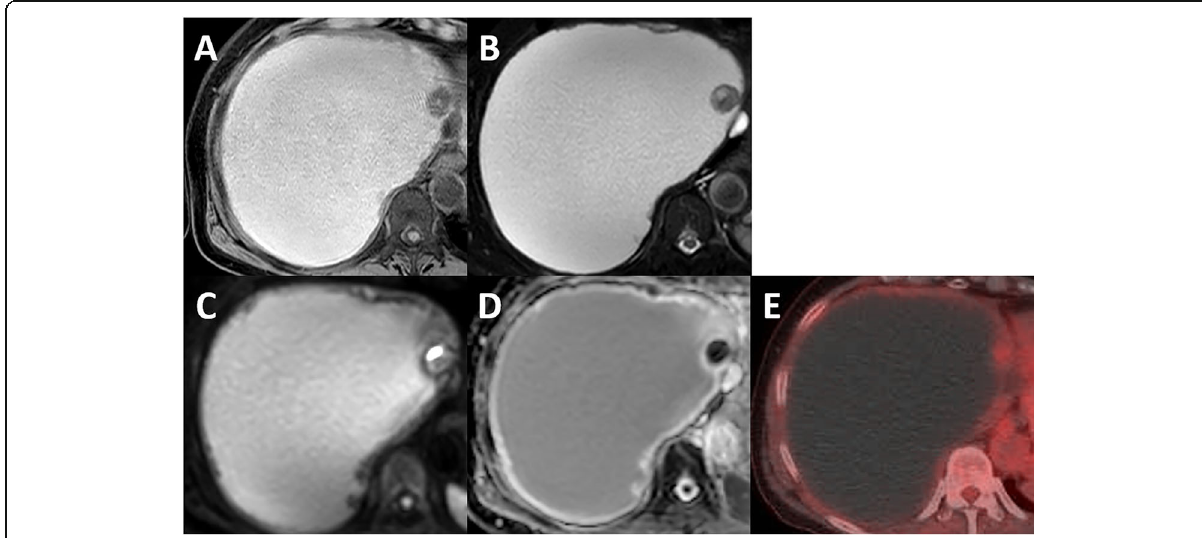
Fig. 2 MRI and FDG-PET images of the ventral mural nodule. a MRI showed that the cyst content was a high-signal and the mural nodule was a low- signal on T1W1. b MRI showed the cyst content was a high-signal and the mural nodule was partially high-signal on T2WI. c MRI showed that the mural nodule was partially strong high-signal on DWI, d with low ADC value (ADC min 0.00mm 2 /s, ADC max 0.91mm 2 /s, ADC mean 0.6×10 − 3 mm 2 /s).